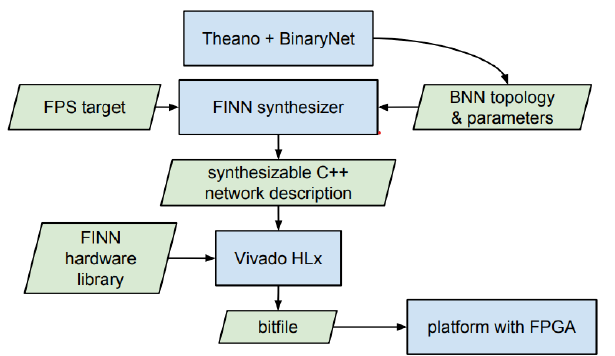
Figure 13. FINN core process .